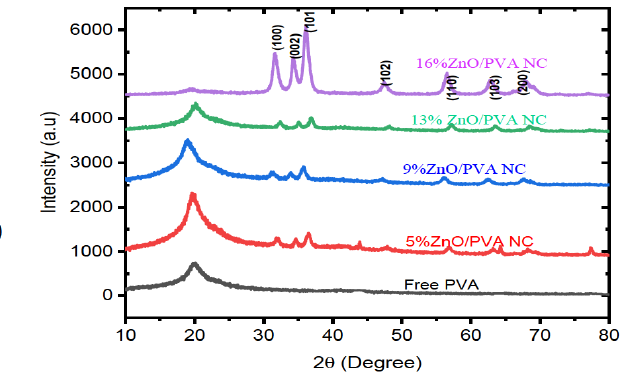
Figure 7: XRD diffraction patterns of ZnO/PVA